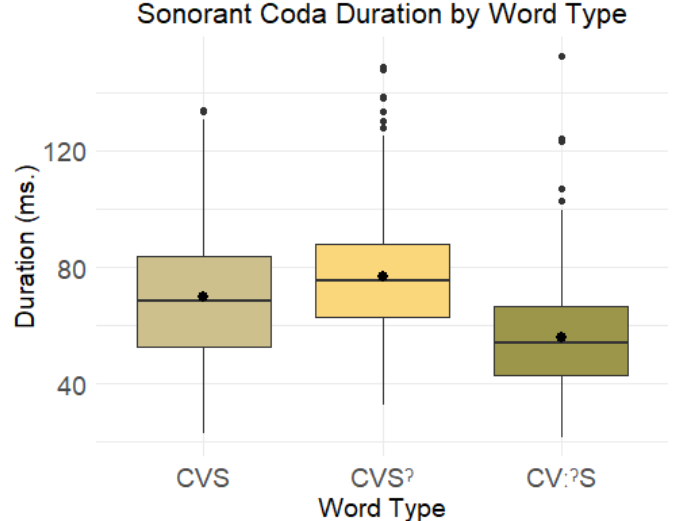
Figure 11. Sonorant coda duration in milliseconds by word type. CVS and CVS ˀ words have signif- icantly longer coda consonants that CV ːˀ S words, but do not differ from each other. Black dots indi- cate the mean sonorant coda duration per word type.